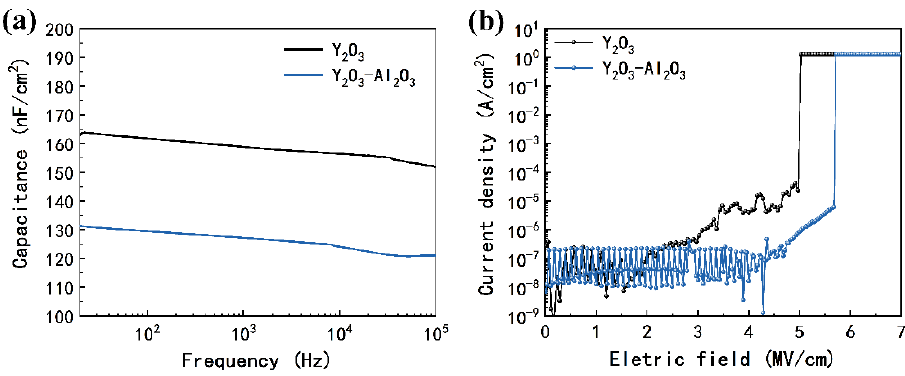
Figure 4. ( a ) Capacitance–frequency curve per unit area of Y 2 O 3 film and Y 2 O 3 –Al 2 O 3 film ( b ) Leak- age characteristic curve of Y 2 O 3 film and Y 2 O 3 –Al 2 O 3 film.